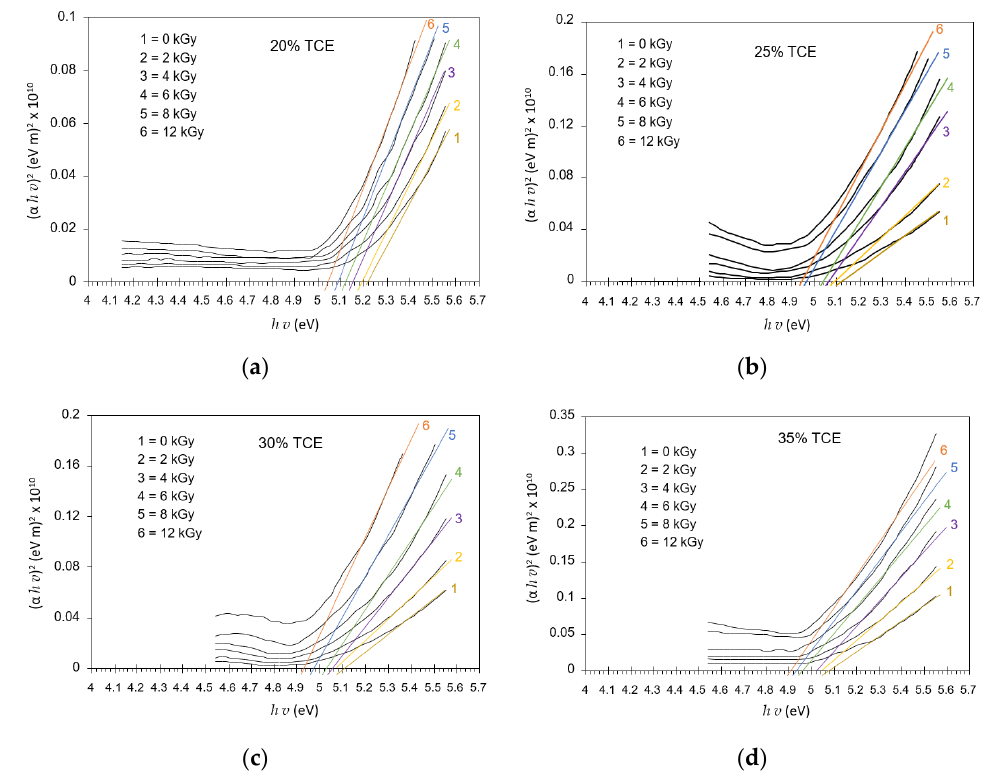
Figure 11. Variation of direct allowed transition ( α hv ) 2 vs. hv at various doses for PVA-TCE-CR polymer film at; ( a ) 20%; ( b ) 25%; ( c ) 30%; and ( d ) 35% TCE composition.